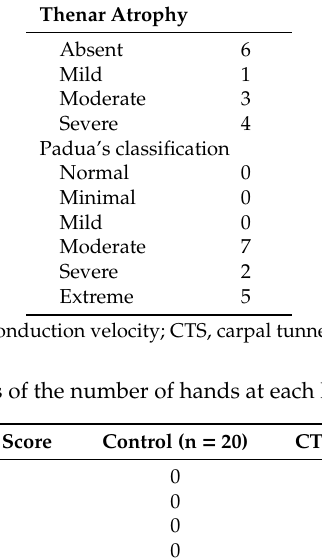
Thenar Atrophy Absent 6 Mild 1 Moderate 3 Severe 4 Padua’s classification Normal 0 Minimal 0 Mild 0 Moderate